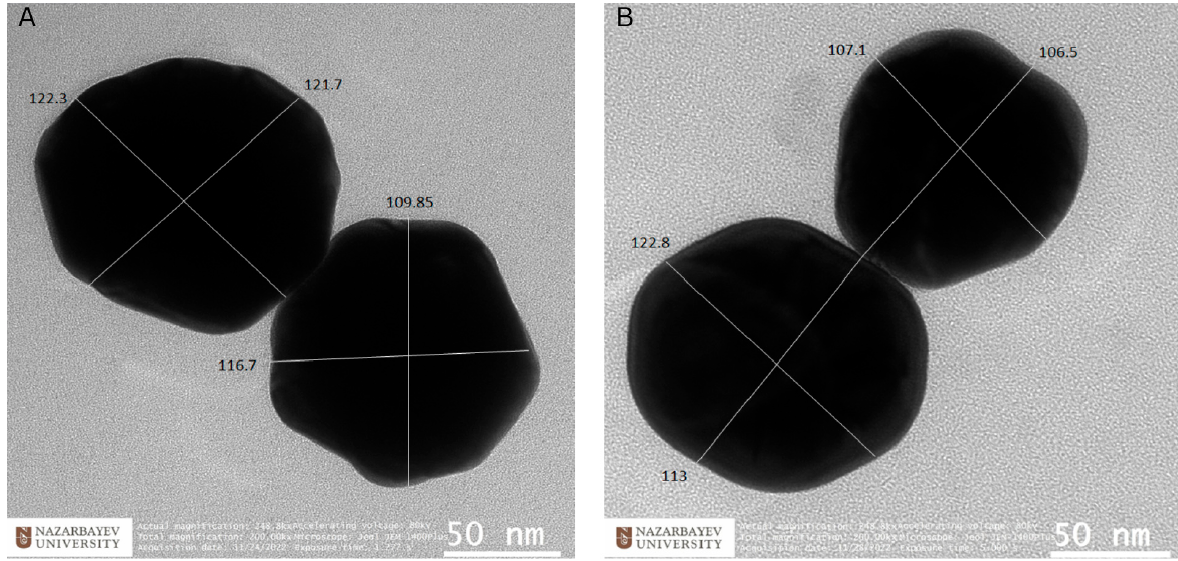
Figure 3. TEM images of 100 nm Au NPs and 100 nm Ag NPs. ( A ) The TEM image of 100 nm Au NPs with a magnification of 200,000. ( B ) The TEM image of 100 nm Ag NPs with a magnification of 200,000.